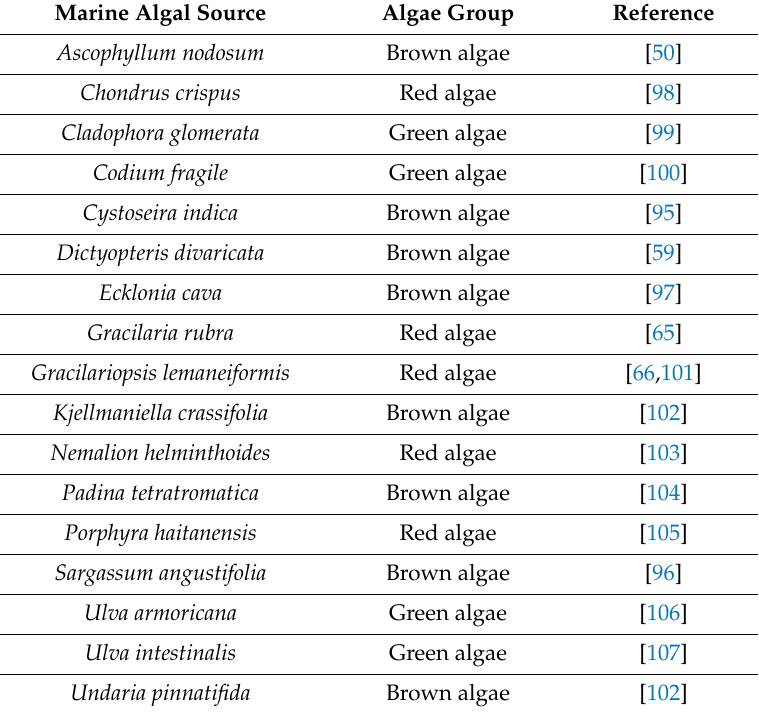
Table 10. Marine algae source with immunomodulatory activity attributed to